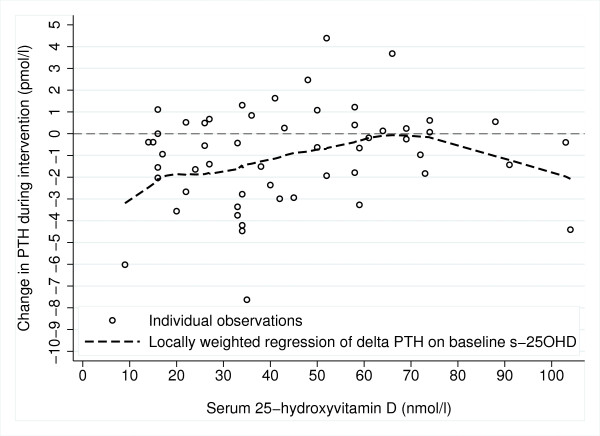
Relationship between vitamin D status at baseline and change in PTH (n = 55).